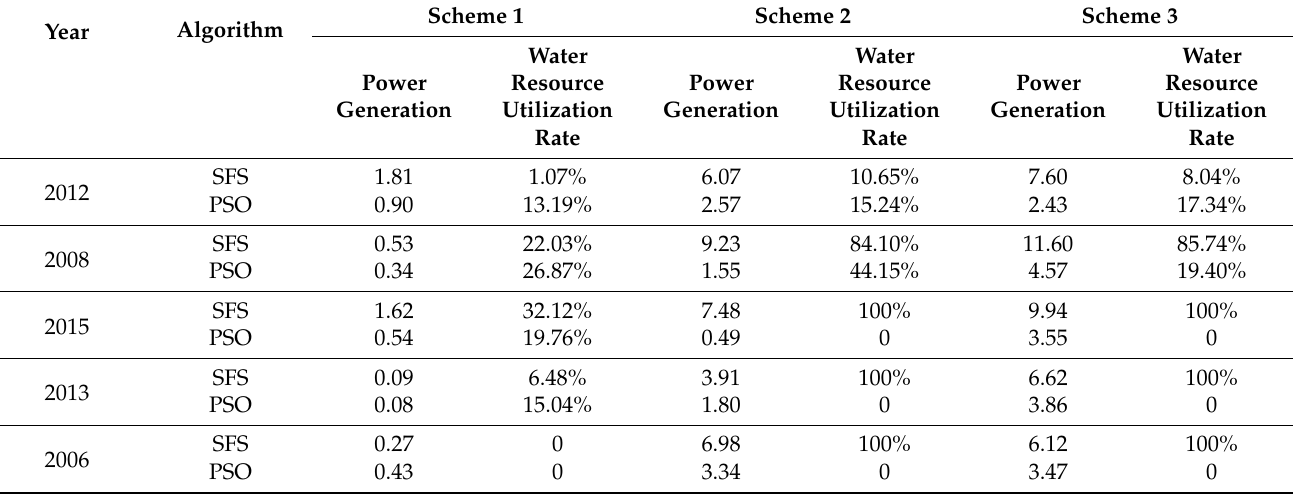
Table 3. Total power generation (10 8 kWh) and water resource utilization rate improved by the ISFS algorithm compared with the SFS algorithm and PSO algorithm.